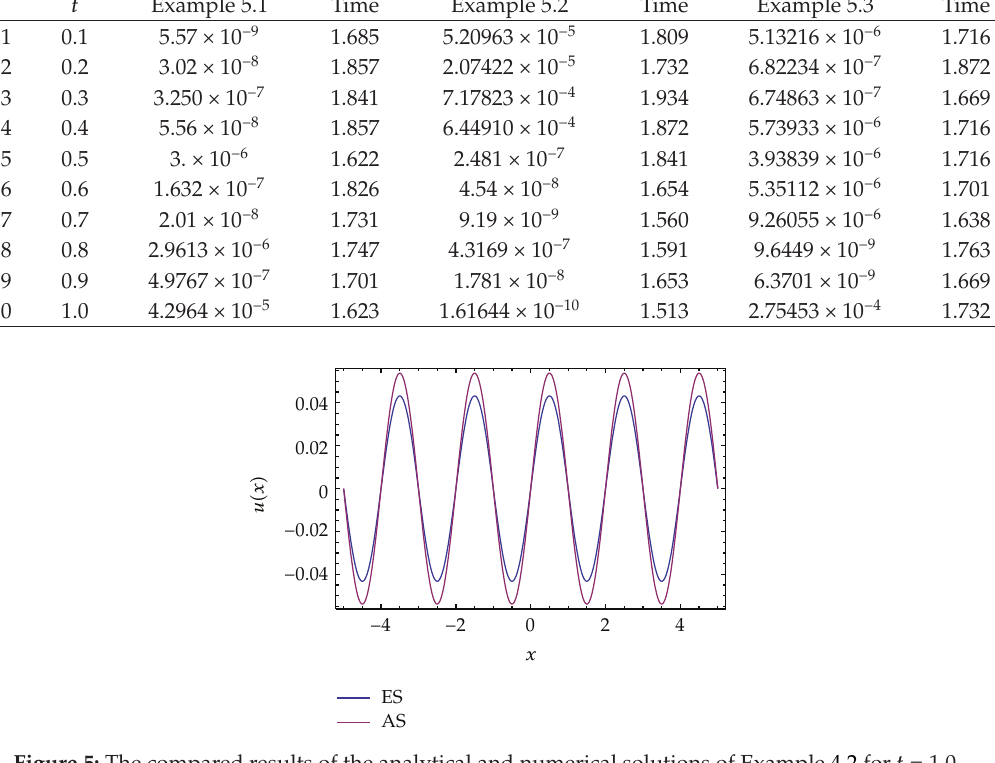
Figure 5: The compared results of the analytical and numerical solutions of Example 4.2 for t (cid:3) 1 .